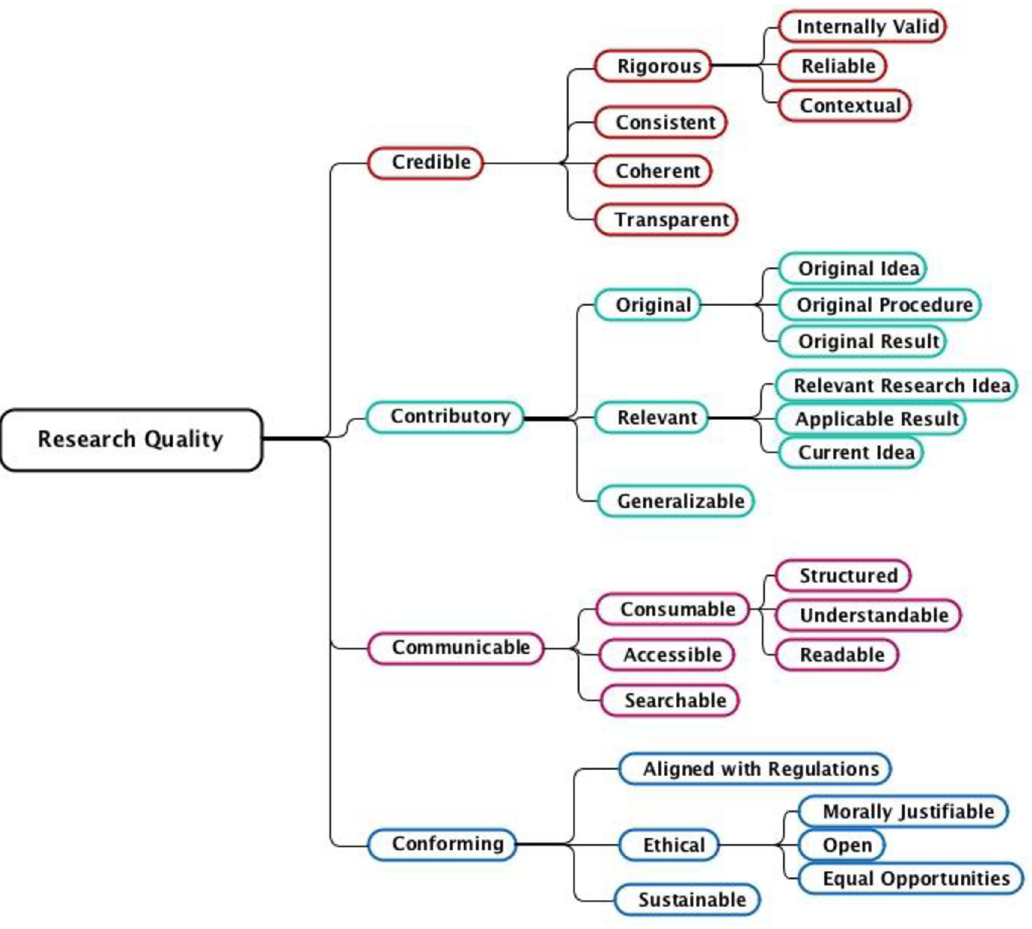
Fig 1. Concept hierarchy of research quality (from M å rtensson et al,